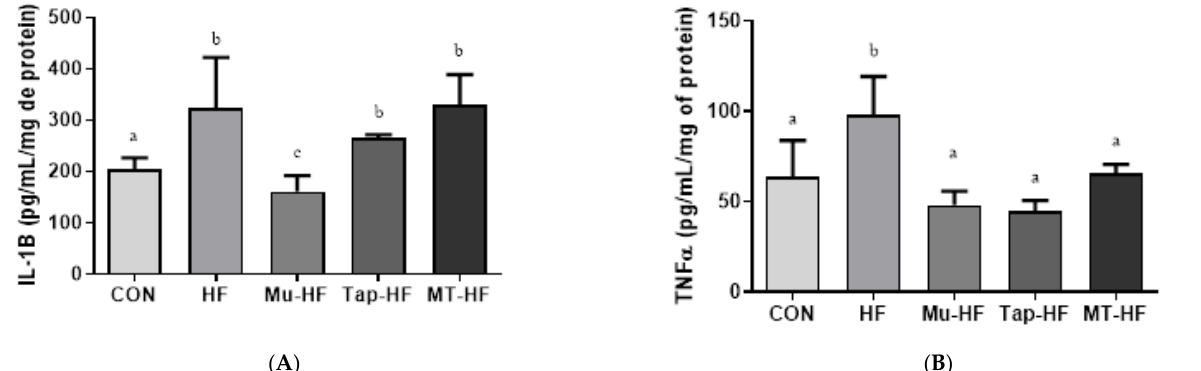
mean ± SD. n = 4 to 10 per group. Means with different letters are significantly different ( p < 0.05, Tukey’s test).